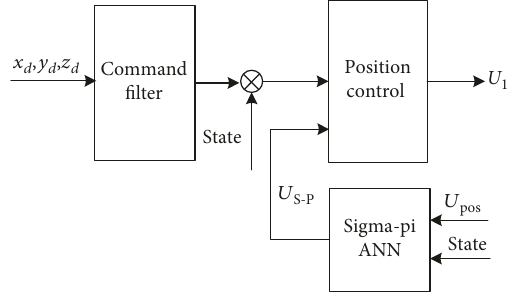
Figure 5: The quadrotor position control loop.